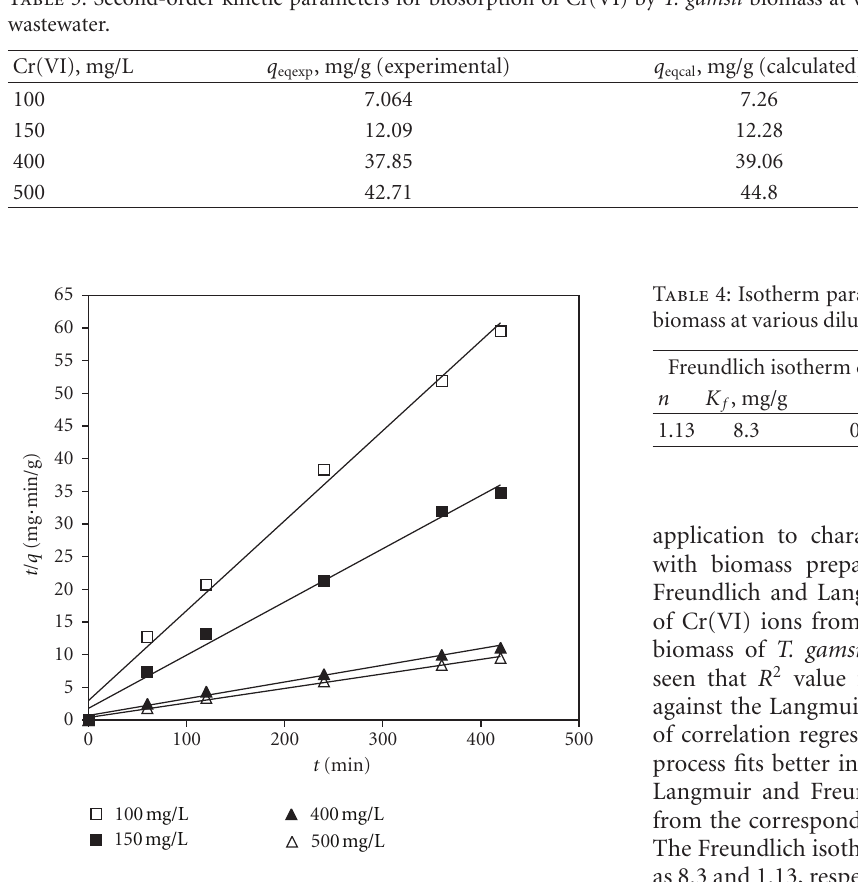
Figure 4: Linearized second-order kinetic plot of Cr(VI) biosorp- tion by T. gamsii biomass at varying initial concentrations of Cr(VI).